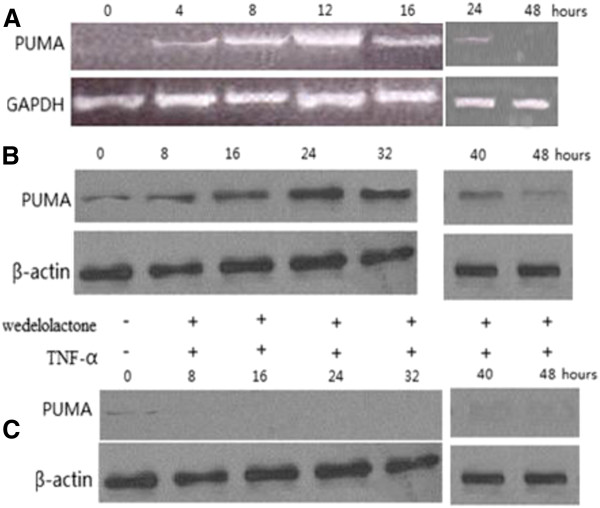
Effect of TNF-α on p53 upregulated modulator of apoptosis (PUMA) expression. (A) Reverse transciption PCR analysis of PUMA mRNA expression in A549 cells following TNF-α treatment. (B) Time course of PUMA protein induction by TNF-α in A549 cells. (C) Induction of PUMA protein by TNF-α or wedelolactone treatment for different times.